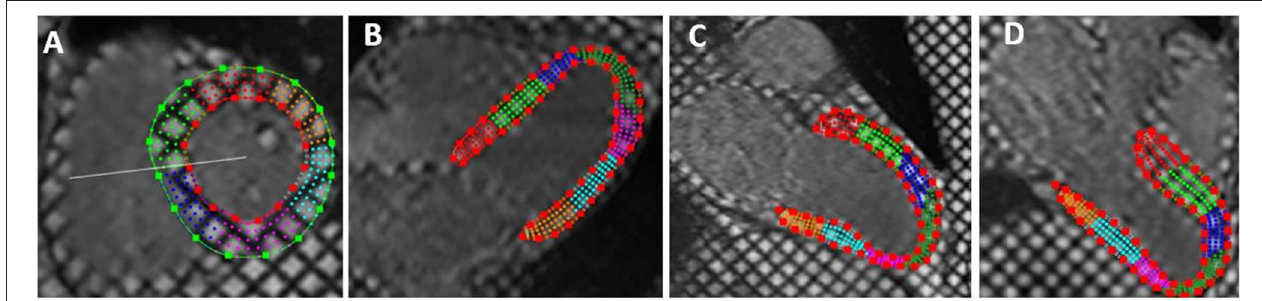
FIGURE 2 | Tagged cardiac magnetic resonance imaging with epicardial and endocardial border tracing in: short axis (A) , horizontal long axis (apical four chambers) (B) , vertical long axis (apical two chambers) (C) , and left ventricular outflow view (three chambers views) (D) . The short axis images were used for estimation of circumferential strain while long axis views were used for estimation of longitudinal strain.